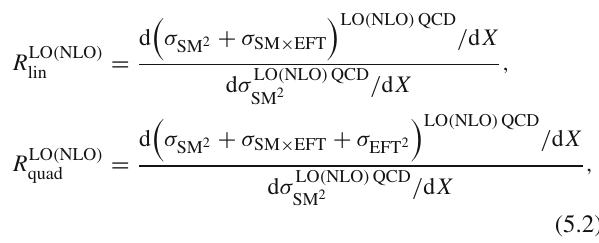
Table 3 Integrated cross section for WZ production at in the ATLAS and CMS setups of Eqs. (4.7) and (4.8), respectively. In the first column W + Z (W − Z) is a short-hand notation for the process Setup